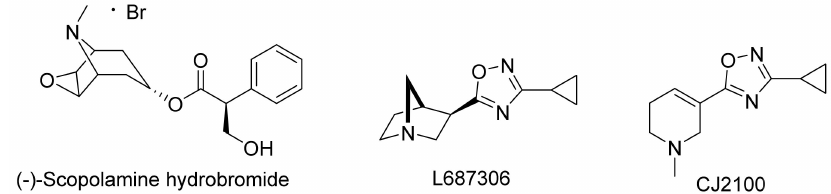
Figure 8. Examples of potential antidepressants targeting the